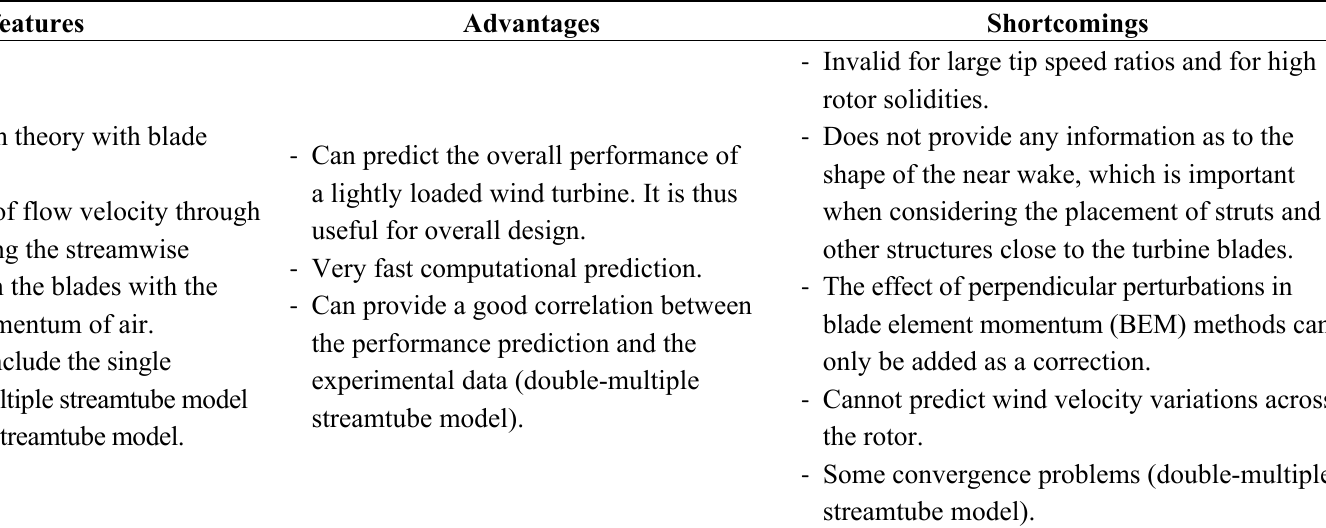
Table 1. Features, advantages and shortcoming of different aerodynamic models for vertical-axis wind turbine ( VAWT)